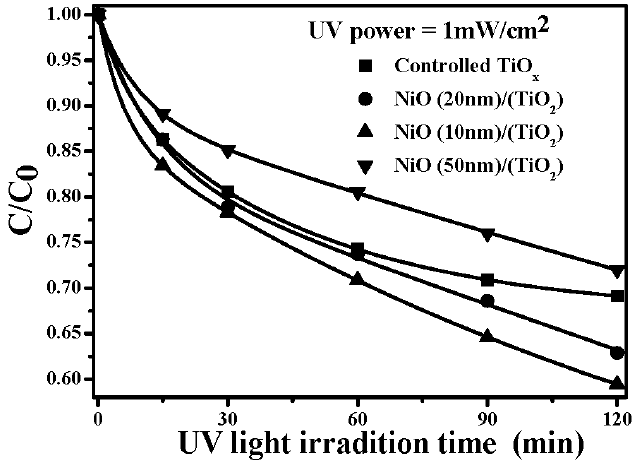
Figure 7. A schematic energy band diagram of the 550 °C annealed p -NiO/ n -TiO 2 heterojunction structure.